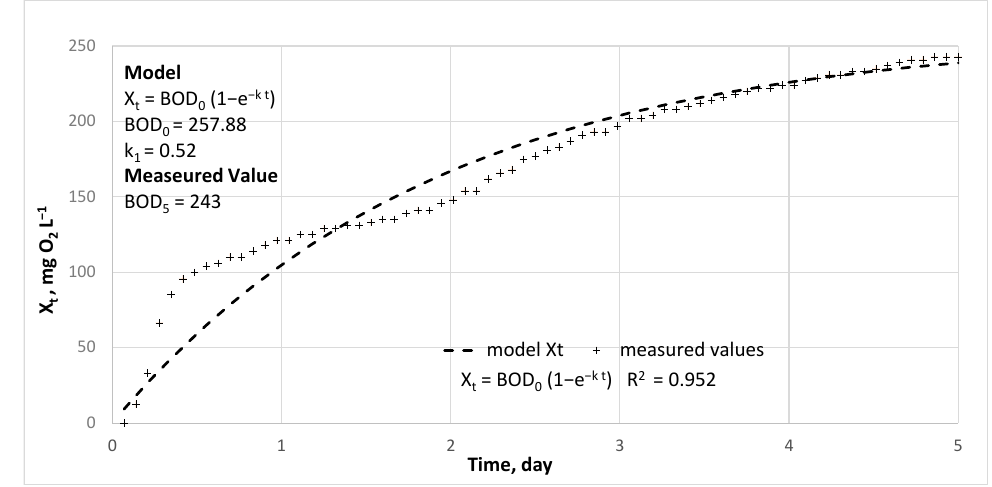
Figure 5. Value of biochemical oxygen consumption in rejected water, WWTP 1, sample 2.